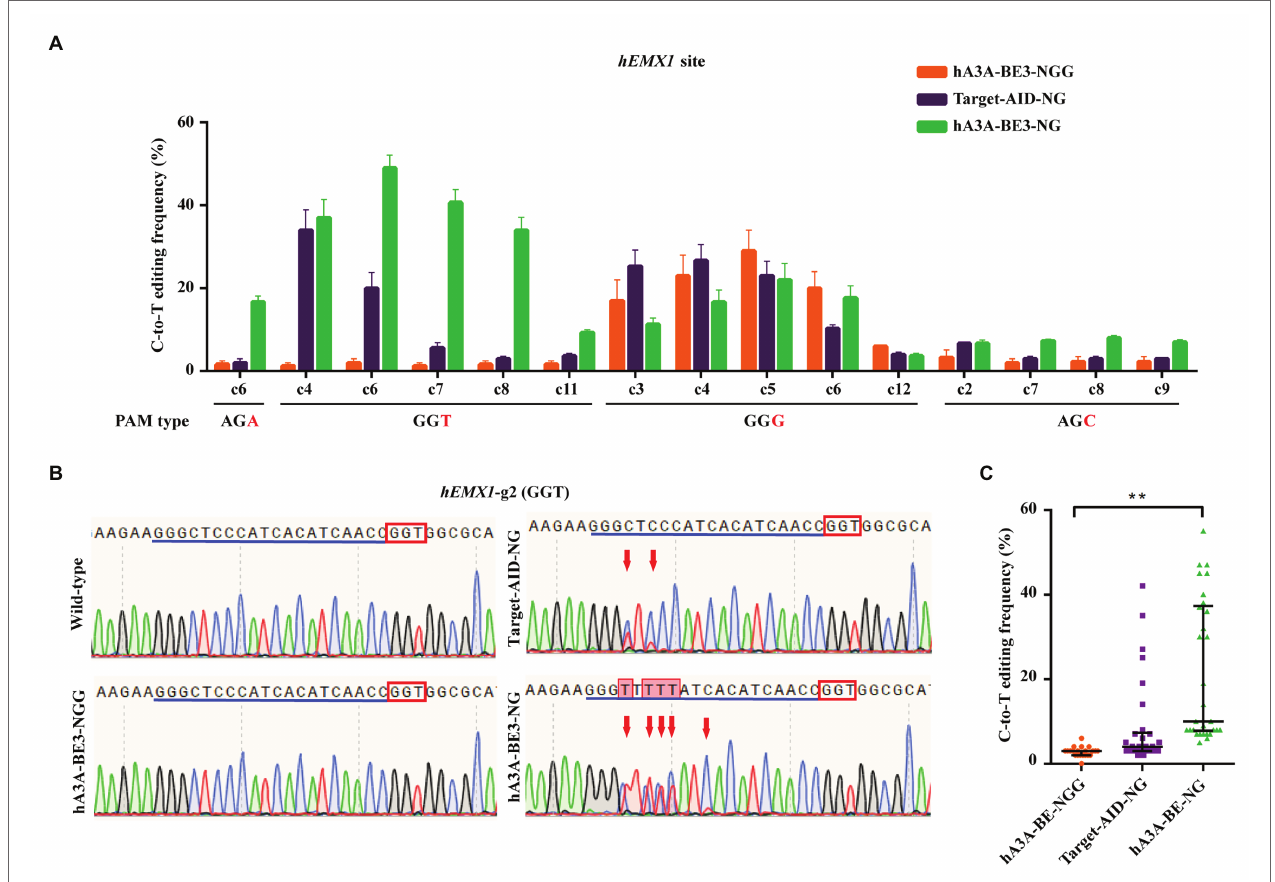
FIGURE 2 | Efficient C-to-T conversion in human HEK293T cells by hA3A-BE3-NG. (A) C-to-T editing by hA3A-BE3, hA3A-BE3-NG, and Target-AID-NG at four endogenous EMX1 gene sites in human HEK293T cells. The target base in the editing window is shown, counting the end distal to the PAM as position 1. Data are represented as the mean ± SEM ( n = 3). (B) Sanger sequencing results of HEK293T cells transfected with hA3A-BE3, hA3A-BE3-NG, or Target-AID-NG. Red boxes indicate PAMs and blue lines indicate sgRNA sequences. Red arrows indicate substituted nucleotides. (C) Statistical analysis of the C-to-T editing frequency induced by hA3A-BE3, hA3A-BE3-NG, or Target-AID-NG at NGH PAM sites in (A) . The median and interquartile range (IQR) are shown; ** p <